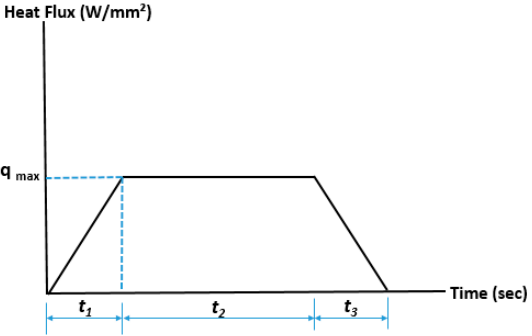
Figure 6. Heat input model with ramp function.